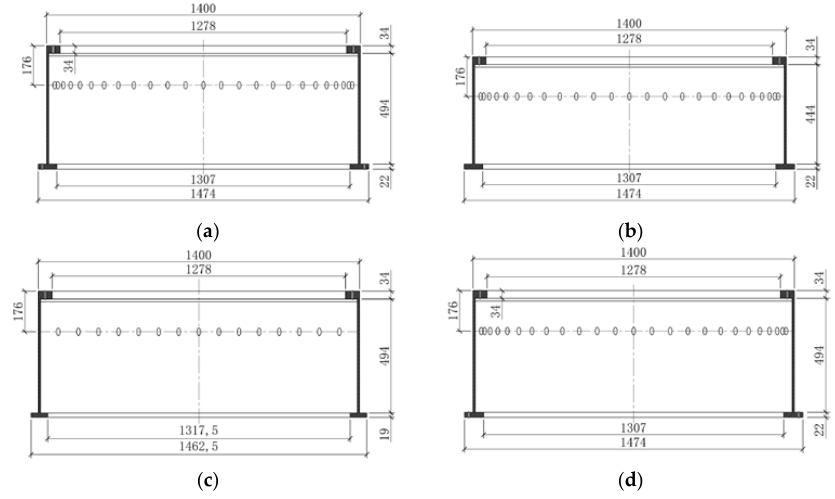
Figure 4. Four test specimens of the 1:3 scale foundation ring: ( a ) ZT-1, with the original size of a standard scale specimen; ( b ) ZT-2, with reduced foundation ring depth; ( c ) ZT-3, with reduced width